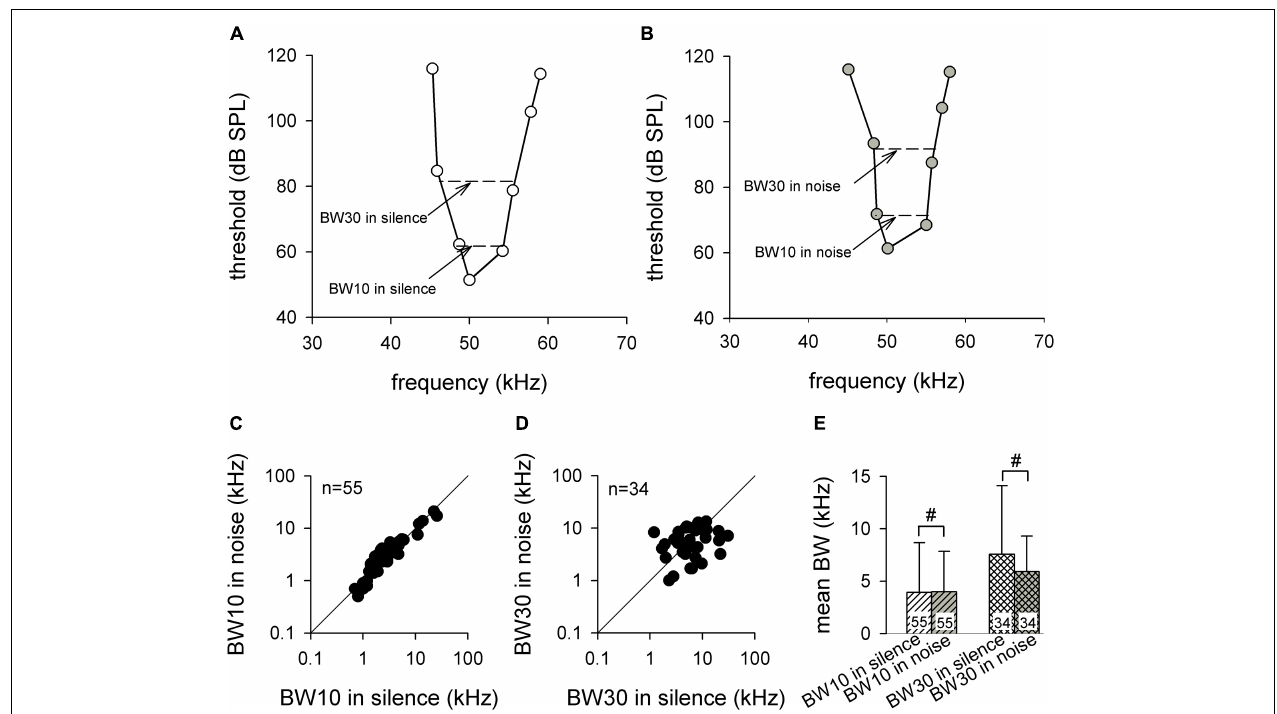
FIGURE 5 | The frequency selectivities of auditory midbrain neurons in silence and noise conditions. (A,B) A representative frequency tuning curve for auditory midbrain neurons in silence (A) and noise (B) conditions. The dashed line shows the method for obtaining BW10 and BW30. (C,D) The distribution of BW10 (C) and BW30 (D) in noise compared with silence. The solid line is the line of equality. (E) Comparison of the mean BW10 (left) and BW30 (right) between silence and noise conditions. BW, bandwidth. # p >